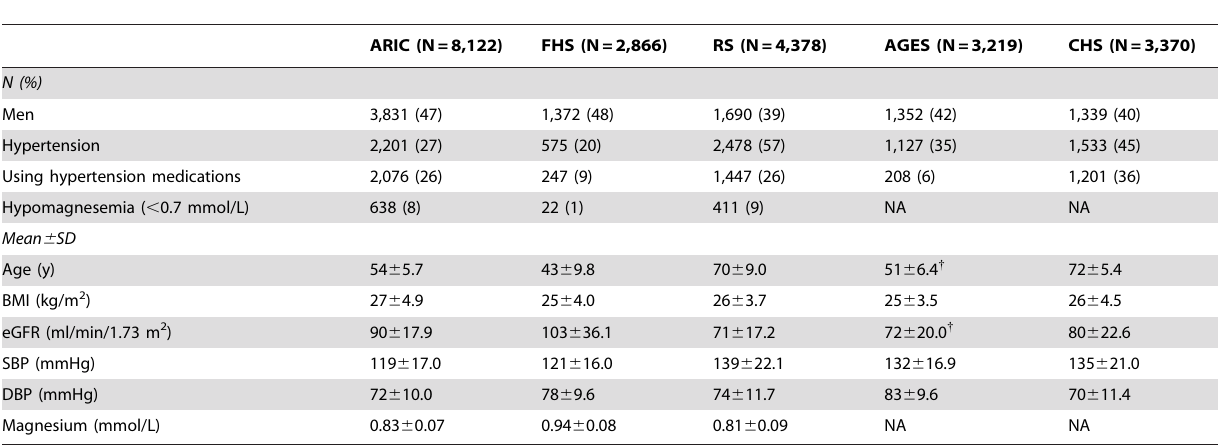
Table 1. Baseline characteristics of the CHARGE Consortium discovery